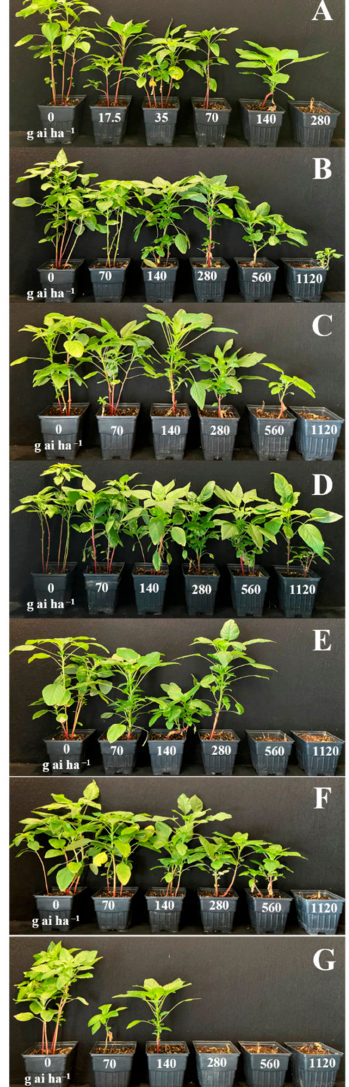
Figure 1. Amaranthus palmeri accessions susceptible and resistant to fomesafen in greenhouse dose– response experiment. Pictures were taken 3 weeks after treatment with 6 doses of fomesafen, Altheimer Laboratory, University of Arkansas, Fayetteville, USA 2020. Each letter represents one specific accession: ( A ) susceptible; ( B ) LAW-E; ( C ) NM-J; ( D ) PEM-F; ( E ) PHI-C; ( F ) PHI-I; ( G ) SC-C. The first pot to the left of each photo was nontreated. Fomesafen doses were in g ai ha − 1